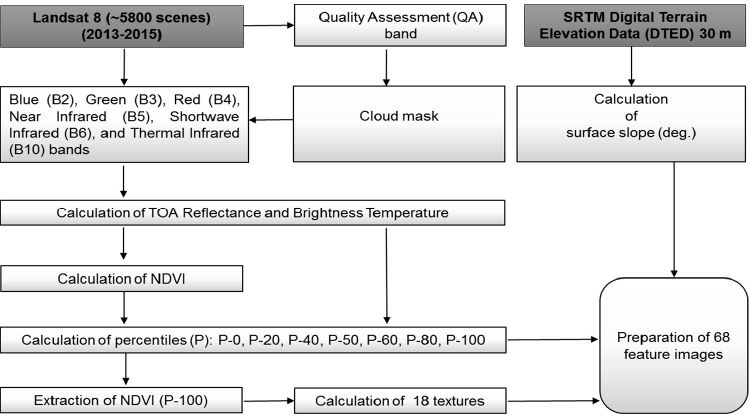
Figure 1. The data processing steps involved in the preparation of feature images used in the research. The input datasets are shown in bold.